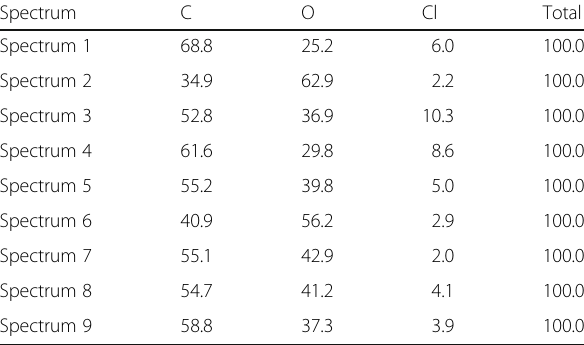
Table 2 The mass distribution (% wt ) of elements in different areas of the composite surface with 50 phr of LiClO 4 Spectrum C O